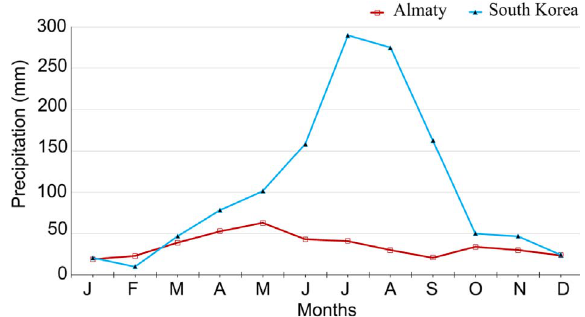
Figure 1. Comparison of the cumulative monthly precipitation (mm) at Almaty (Kazakhstan) and South Korea over 20